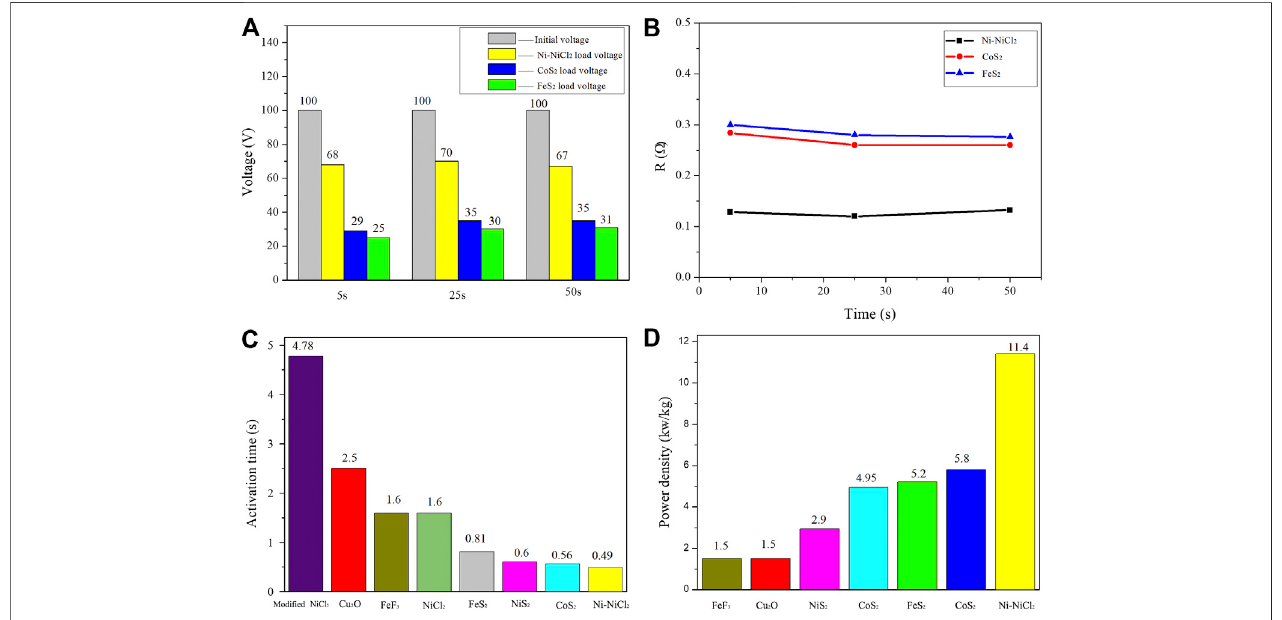
FIGURE7|(A) Voltagedropand (B) internalresistanceof100 Vthermalbatteriesaftertheloadingofpulsecurrentdensity(6 A/cm 2 ,10 ms)at5,20,and50 s. (C) Activation time and (D) power density of different thermal